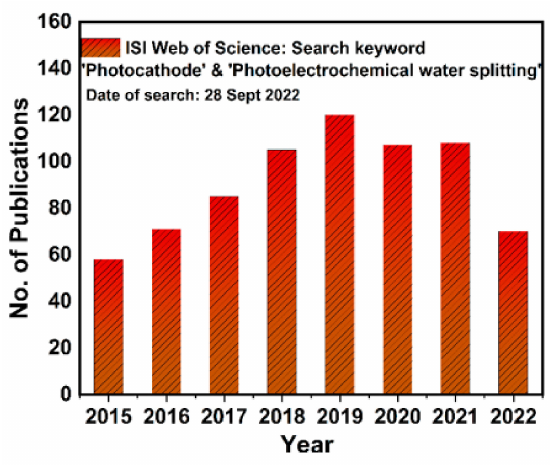
Figure 1. Year-by-year publications of photocathode research on PEC devices, the keywords were set to (“photocathode” and “photoelectrochemical water splitting”). Data are obtained from the ISI Web of Science, dated 28 September